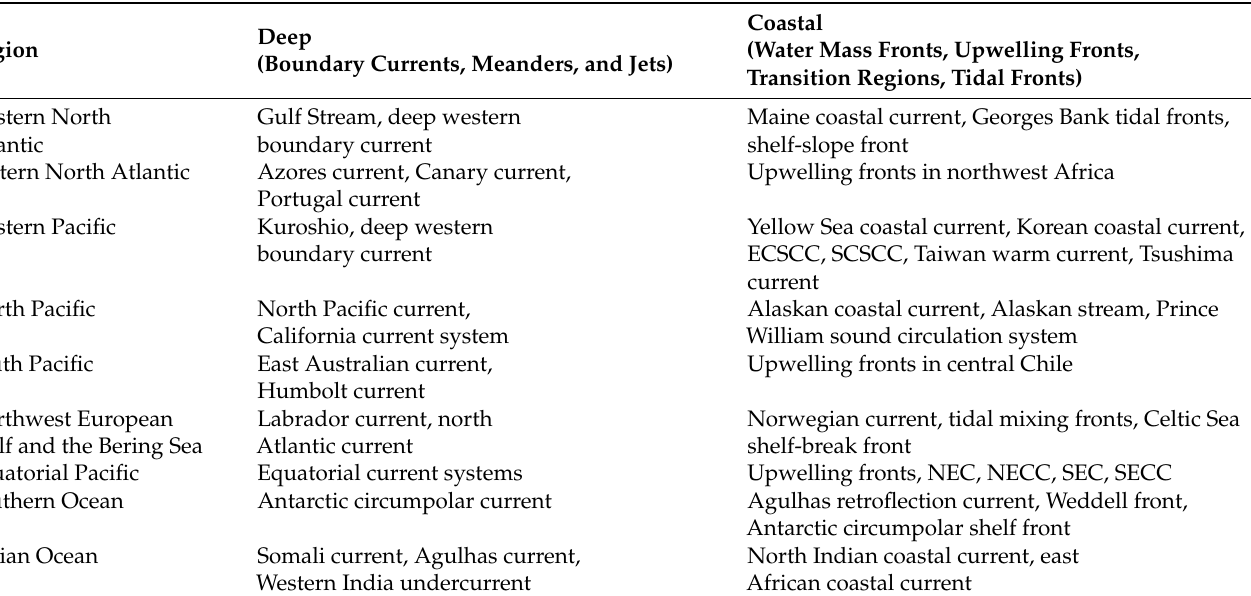
Table 3. The feature model classification of ocean fronts in the world’s oceans [61]. ECSCC: